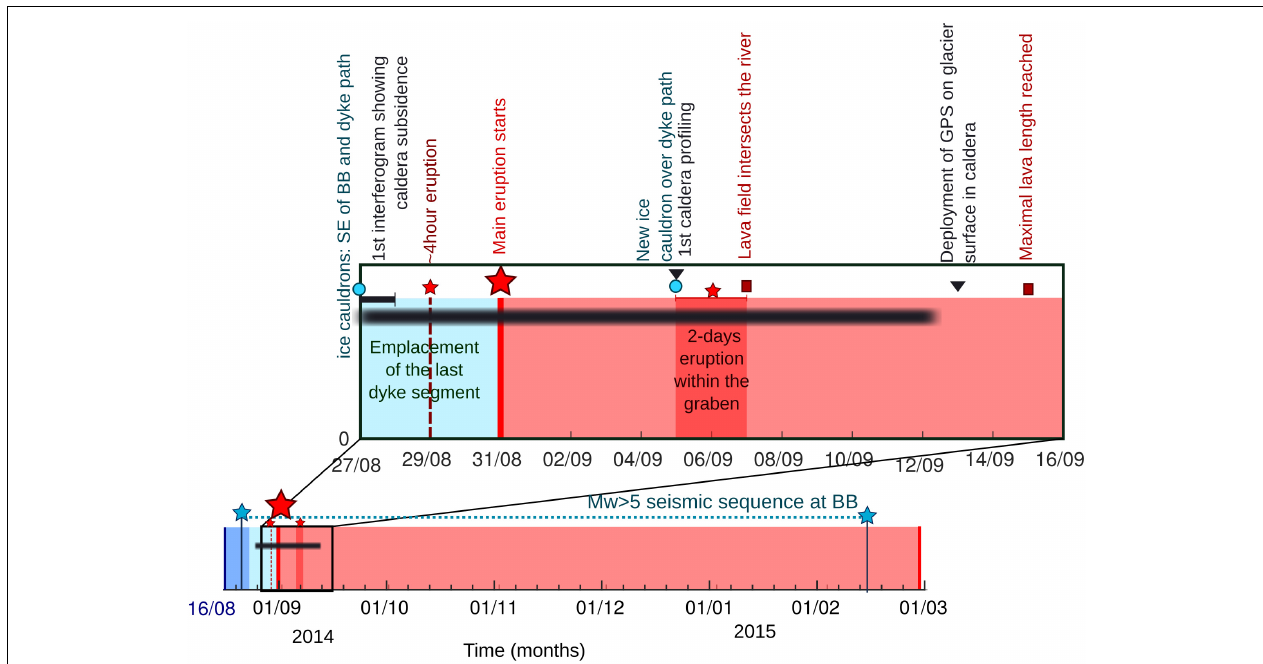
FIGURE 10 | Timeline of the main events during the unrest at Bár ð arbunga and Holuhraun eruption. The seismic unrest is depicted by the blue areas with the lighter area showing the propagation of the last dyke segment including both beneath and north of Vatnajökull glacier. The red area shows the main effusive eruption. The red dashed line and smaller red area with related red stars show the two other eruptions that occurred during this eruptive period. The inset emphasizes events between late August and mid-September with the detection of ice-cauldrons (blue circles), and other eruption related events with red symbols. The dates indicated for the ice-cauldrons relate only their time of discovery, not formation (Reynolds et al., 2017). The black symbols (small horizontal bar and inverted triangles) indicate key dates for instrument deployment/data acquisition that provided valuable information for the volcano monitoring and the understanding of physical processes. The black horizontal and thick bar represents the period when first results of the feeder dyke modeling were obtained. BB stands for Bár ð